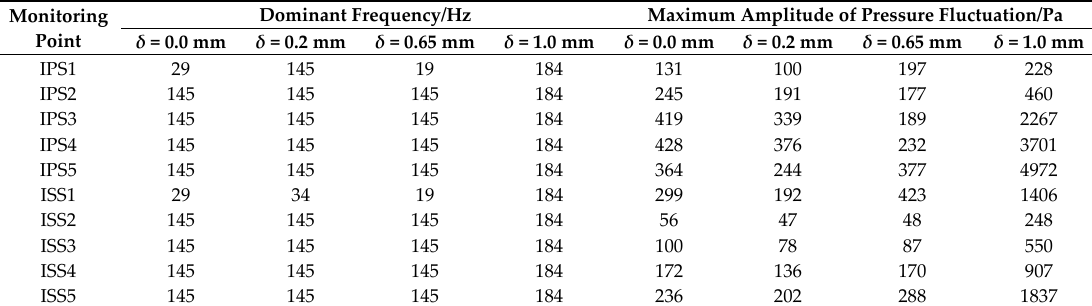
Table 4. Spectrum analysis of pressure fluctuations on IPS1–5 and